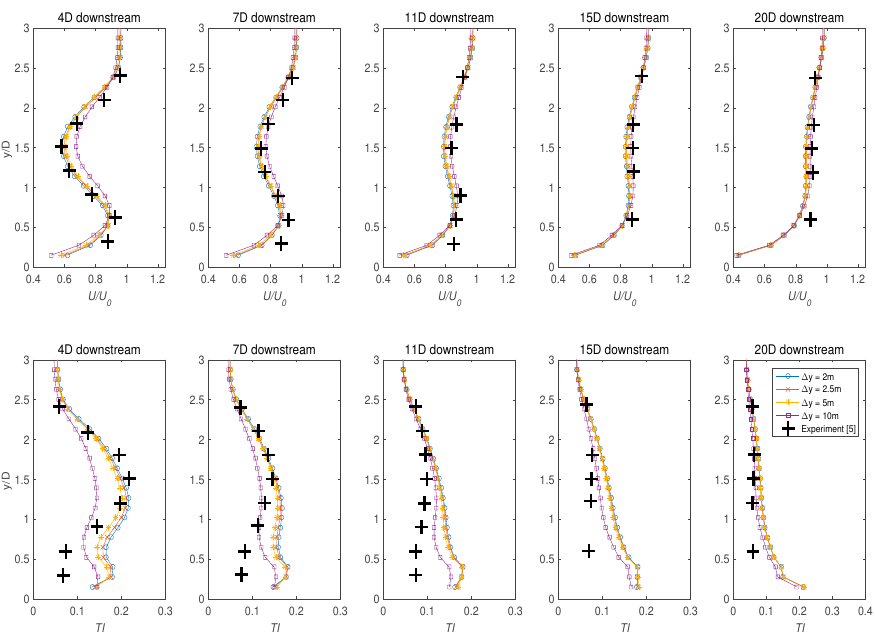
Figure 8. The influence of ∆ y resolution on the flow at increasing distances downstream of the turbine. The value of ∆ y was varied, while ∆ x and ∆ z were maintained at 2 m and 24 sigma layers, respectively for all cases.